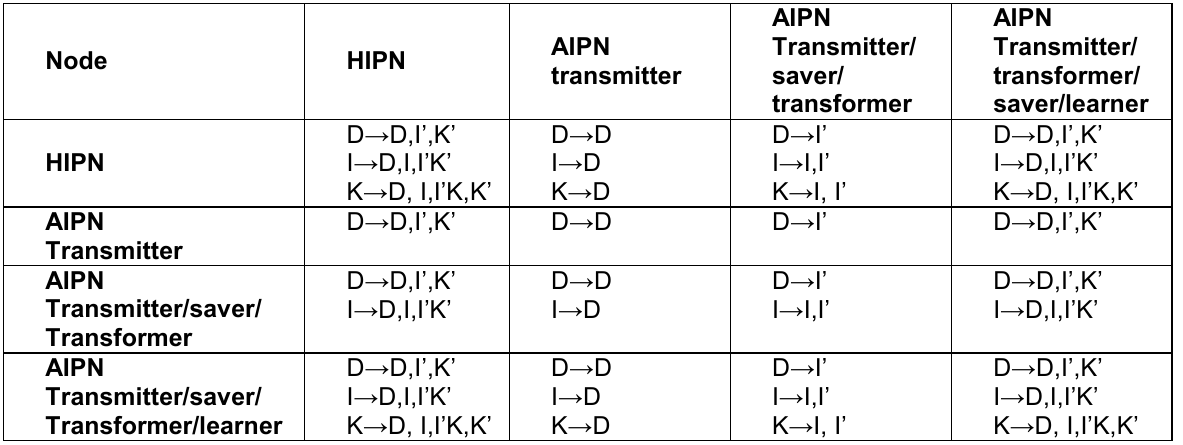
Table 1. Information handling capabilities of IPNs